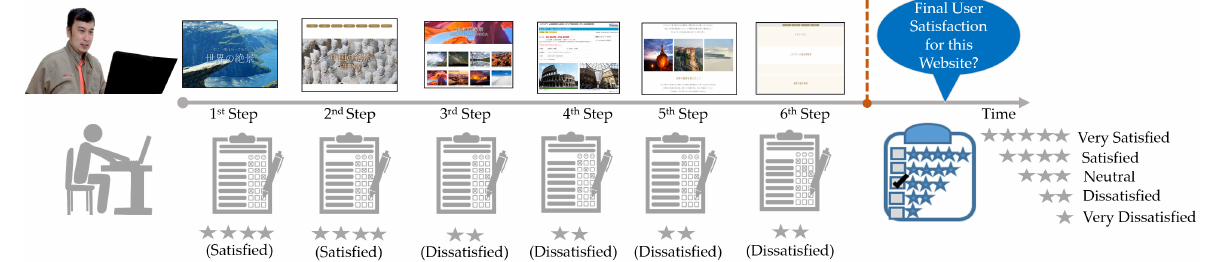
Figure 7. Evaluating user satisfaction while using a travel agency website.